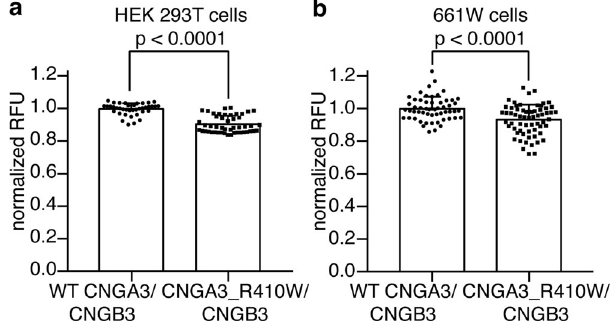
Fig. 6 The mutant channel causes cell death. Cell viability of HEK 293T ( a ) and 661W cells ( b ) 48 h after transfection with WT or mutant CNGA3/ CNGB3. Each point represents one well of cells from one of six different cultures. Data are presented as mean ± SD. Statistical signi fi cance was evaluated with Student ’ s t